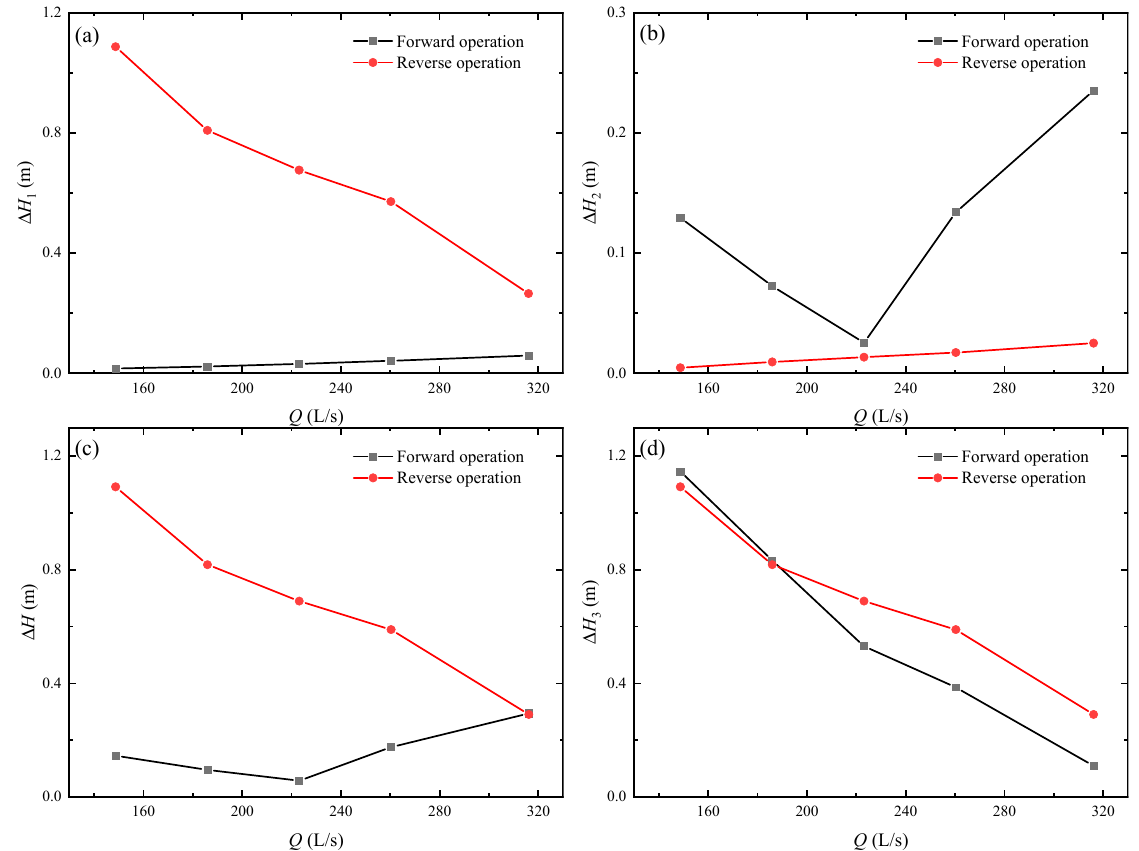
Figure 10. Streamline distributions at flow rate Q = 250.85 L/s in: ( a ) forward operation; ( b ) reverse operation.